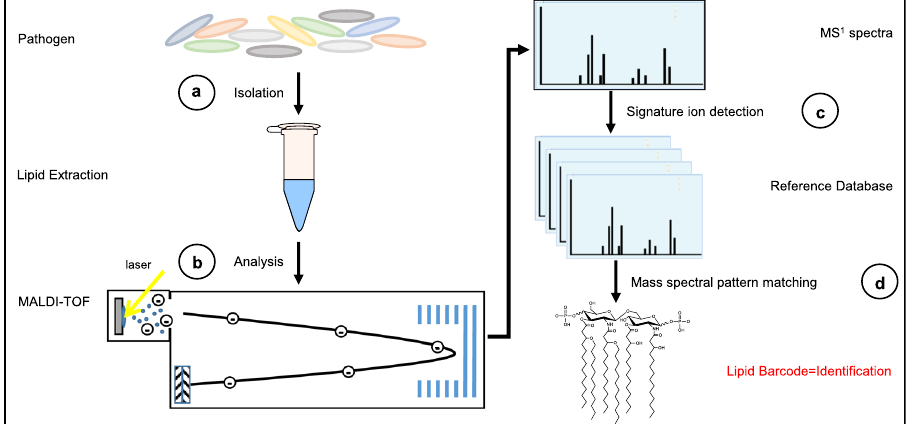
Figure 1. Strategy for glycolipid-based mass spectrometry platform for pathogen identification. ( a ) Microbes are isolated from pure culture or biological specimen and whole cell lipids are extracted by hot ammonium- isobutyrate ( b ) Lipid extracts are purified and analyzed by MALDI-TOF-MS ( c ) A mass spectrum of membrane glycolipids is acquired and compared against an extensive reference database of mass spectral profiles from known organisms via pattern-matching to ( d ) Generate a digital identification output and an assigned confidence score.